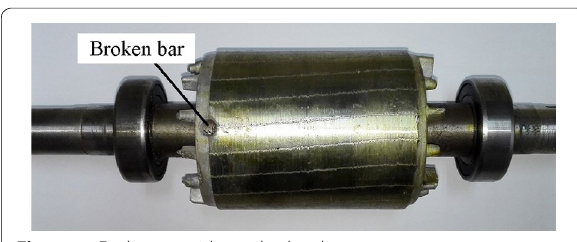
Figure 5 Fault rotor with one broken bar